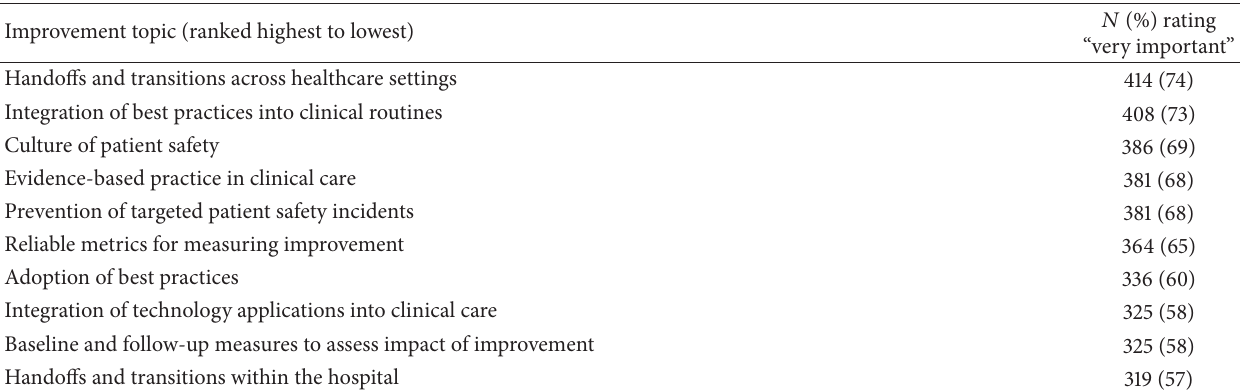
Table 4: Top ten improvement topics ranked by frequency of “very important” rating ( 𝑛 = 560